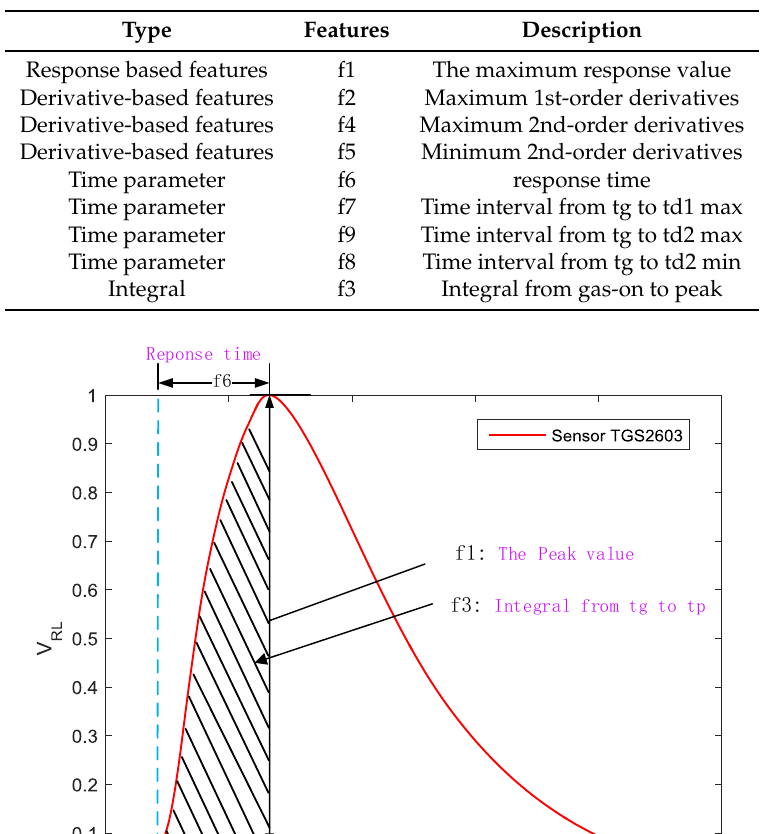
Table 1. Feature types and descriptions used in gas classification.